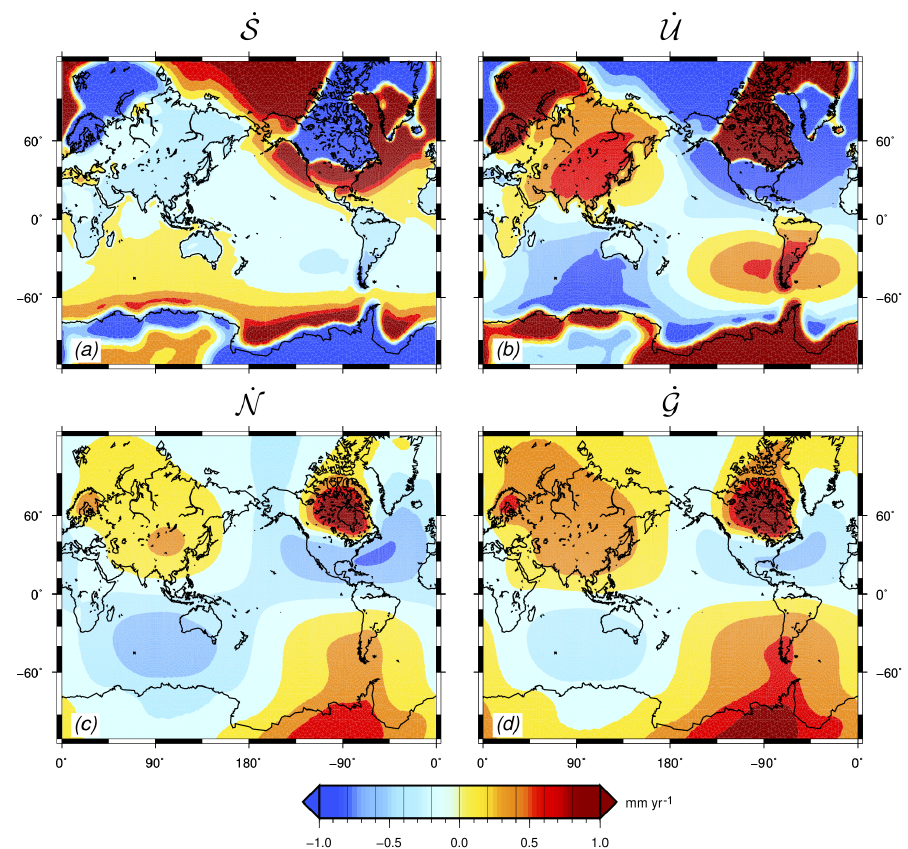
Figure 8. Present-day GIA fingerprints obtained for the test run with R44/L128/I3 . Note that the color table is saturated in a narrow interval. The effects of Earth rotation, evaluated according to the revised rotation theory, can be well discerned for ˙ N and ˙ G , with the characteristic high-amplitude lobes with a harmonic degree l = 2 and order m = 1 symmetry (Spada and Galassi, 2015). Spatial averages of these maps are given in Table 4. Min/max values for ˙ S , ˙ U , ˙ N , and ˙ G , after rounding the SELEN 4 outputs to one decimal figure, are − 13 . 3 / 4 . 9, − 5 . 2 / 14 . 2,